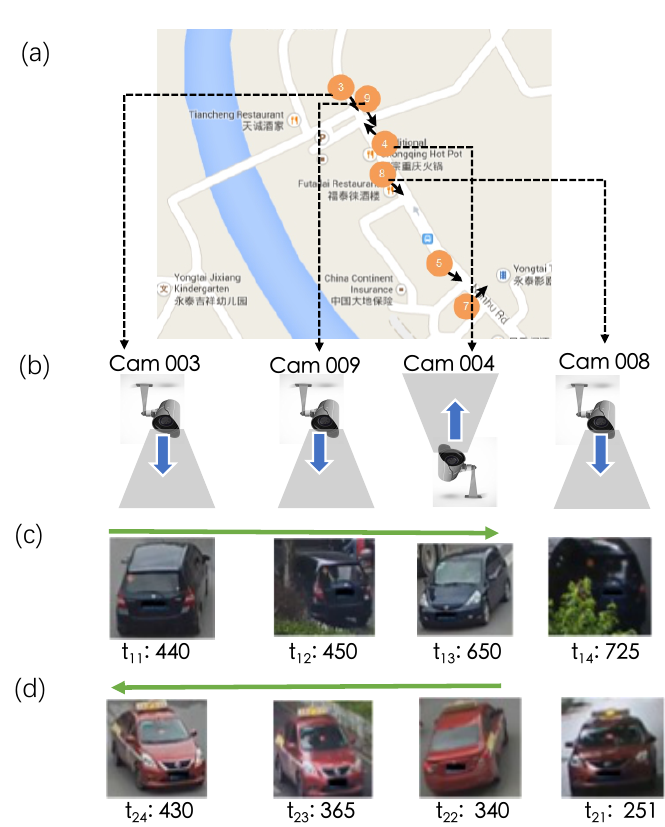
Figure 3. Relationship of vehicles’ spatiotemporal information and vehicles’ poses. ( a ) Map and camera topology. ( b ) Viewing directions of cameras. ( c ) Changes in spatiotemporal data and poses of a vehicle as it drives from cam_003 to cam_008. ( d ) Changes in spatiotemporal data and poses of a vehicle as it drives from cam_008 to